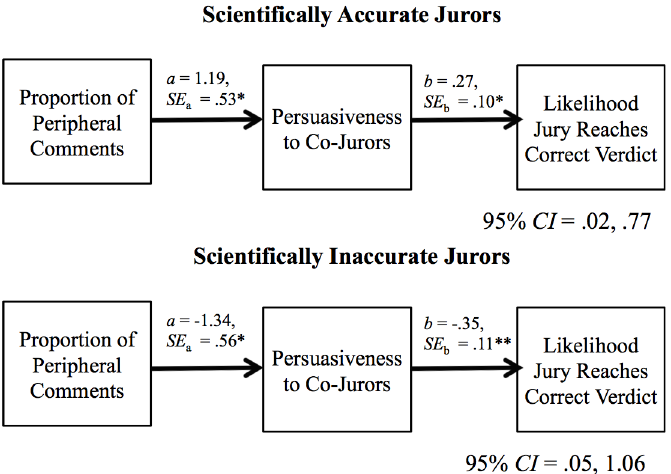
Fig 6. The indirect effect of peripheral comments on scientifically accurate verdicts through individuals’ persuasiveness.